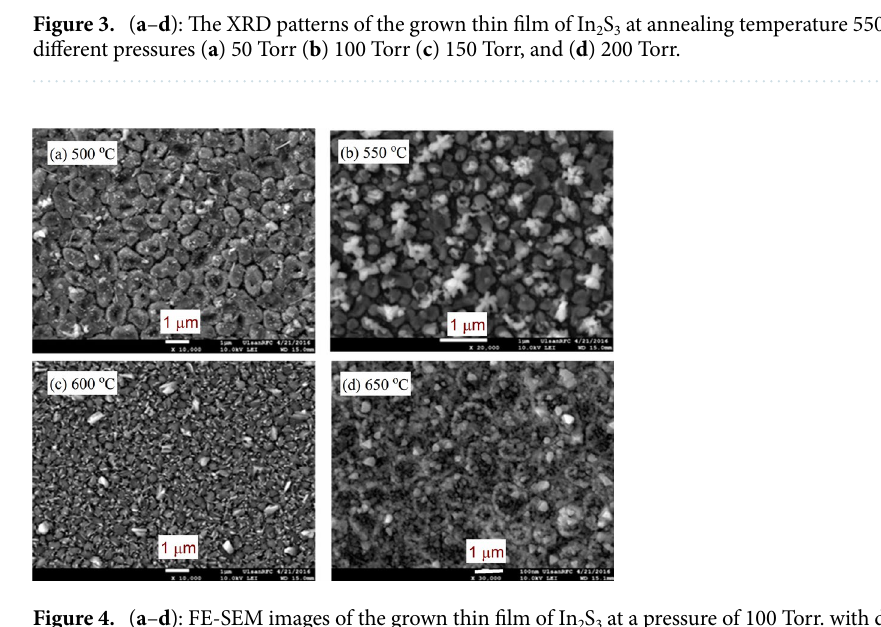
Figure 4. ( a – d ): FE-SEM images of the grown thin film of In 2 S 3 at a pressure of 100 Torr. with different annealing temperatures ( a ) 500 °C, ( b ) 550 °C, ( c ) 600 °C, and ( d ) 650